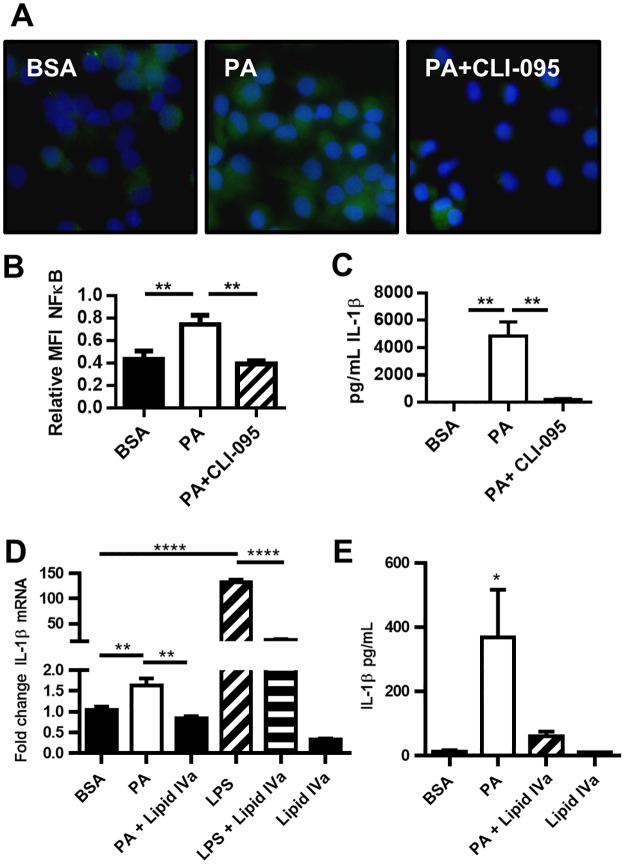
PA activation of NF-κB is TLR4 dependent.(A-B) PA-induced phosphorylation of NF-κBp65 is TLR4 dependent. MoDCs were treated with 300μM PA for 20 min and analyzed for phospho NF-κBp65 (green) by fluorescence microscopy. (B) Quantitation of MFI phospho NF-κBp65 relative to DAPI (blue). (C) MoDC secretion of IL-1β is dependent on TLR4 signaling. MoDCs were treated with 150μM PA for 36hrs +/- CLI-095. The supernatant was analyzed for the concentration of IL1-β. (D) MoDC production of IL-1β mRNAis dependent on TLR4 signaling. MoDCs were treated with 150μM PA for 6hrs +/- Lipid IVa. mRNA was isolated and RT-qPCR was performed. (E) MoDC secretion of IL-1β is dependent on TLR4 signaling. MoDCs were treated with 150μM PA for 36hrs +/- Lipid IVa. The supernatant was analyzed for the concentration of IL1-β. N = 3.